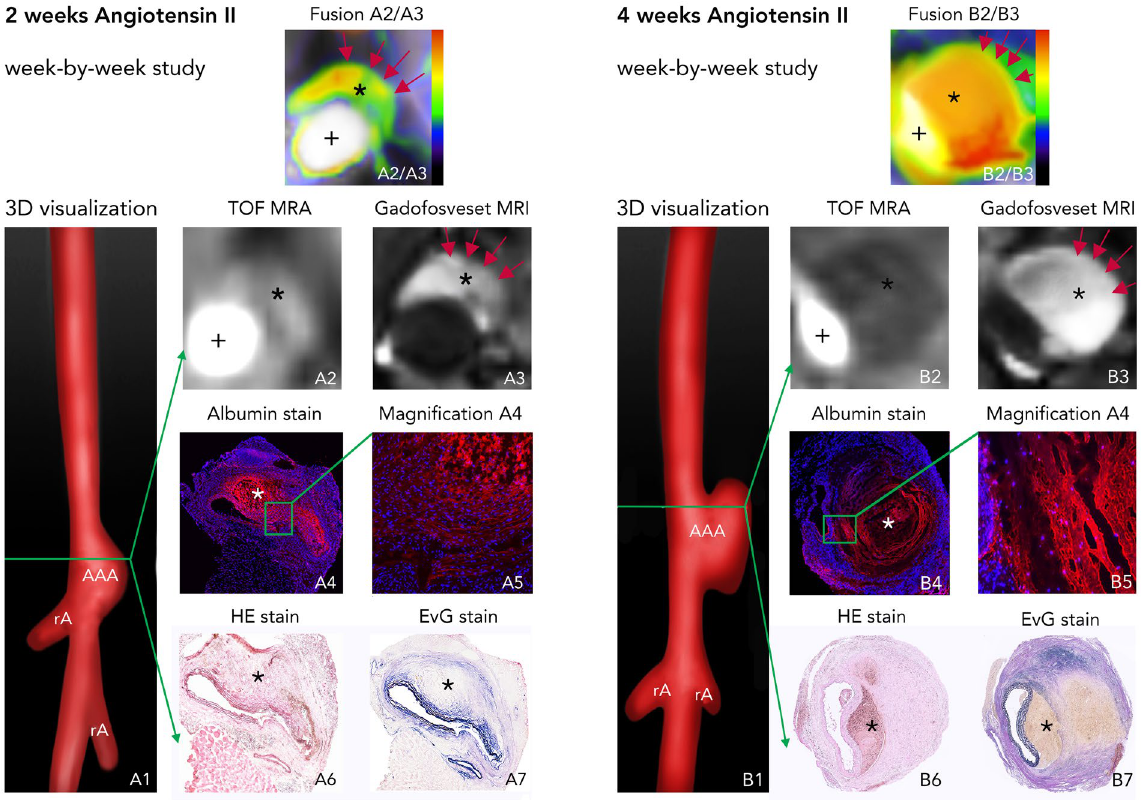
Figure 4. In vivo molecular MRI with an albumin-binding probe during the development of aortic aneurysms (week-by-week study). (A1) 3D visualizations showing the suprarenal abdominal aorta (AA) with the renal arteries (rA) of a male ApoE − / − mouse after 2 weeks of Angiotensin II infusion. The green line indicates the orientation of subsequently acquired transverse MRI sequences and the corresponding histological sections. (A2) Time-of-flight angiography of the AA showing the vessel lumen. (A3) Delayed-enhancement imaging after administration of the albumin-binding probe gadofosveset shows intermediate signal enhancement after 2 weeks of AngII infusion, indicated by the red arrows and corresponding to albumin accumulation in the arterial wall and the thrombus area. Fusion A2/A3 shows a fusion of images A2 and A3 for better visualization of in vivo results. Blue signal indicates lower enhancement, whereas green signal shows intermediate enhancement and red signal indicates increased enhancement. A4–A7 are images of ex vivo histology. A4 and its corresponding magnification A5 show an albumin-specific staining with confluent immunopositive fluorescent areas of albumin, confirming the extraluminal accumulation of albumin. A6 corresponds to a Hematoxylin and Eosin (H&E) staining of the aortic tissue and A7 shows an Elastica van Gieson (EvG) staining of elastic fibers. In summary, we see, that there is pathological vascular permeability in the abdominal aortic aneurysm after 2 weeks of Angiotensin II infusion with intermediate signal enhancement from the albumin-binding probe, corresponding to confluent extraluminal accumulation of Albumin. (B1) 3D visualizations showing the suprarenal abdominal aorta (AA) with the renal arteries (rA) of a male ApoE − / − mouse after 4 weeks of Angiotensin II infusion. The green line indicates the orientation of subsequently acquired transverse MRI sequences and the corresponding histological sections. (B2) Time-of-flight angiography of the AA showing the vessel lumen. (B3) Delayed-enhancement imaging after administration of the albumin-binding probe gadofosveset shows a strong signal enhancement after 4 weeks of AngII infusion, indicated by the red arrows and corresponding to albumin accumulation in the arterial wall and the thrombus area. Fusion B2/B3 shows a fusion of images B2 and B3 for better visualization of in vivo results. Blue signal indicates lower enhancement, whereas green signal shows intermediate enhancement and red signal indicates increased enhancement. B4-B7 are images of ex vivo histology. B4 and its corresponding magnification B5 show an albumin-specific staining with large immunopositive fluorescent areas of albumin, confirming an increasing extraluminal accumulation of albumin. B6 corresponds to a Hematoxylin and Eosin (H&E) staining of the aortic tissue and B7 shows an Elastica van Gieson (EvG) staining of elastic fibers. In summary, we see, that there is a further increase in vascular permeability in the abdominal aortic aneurysm after 4 weeks of Angiotensin II infusion with strong enhancement from the albumin-binding probe, corresponding to extensive extraluminal accumulation of Albumin. Abbreviations: H&E: Hematoxylin and Eosin staining; EvG: Elastica van Gieson staining of elastic fibers; TOF-MRA: time-of-flight magnetic resonance angiography; gadofosveset: albumin-binding probe; AA: suprarenal abdominal aorta; RA: right renal artery; gadofosveset: albumin-binding probe; + : vascular lumen in arterial TOF; * : thrombus